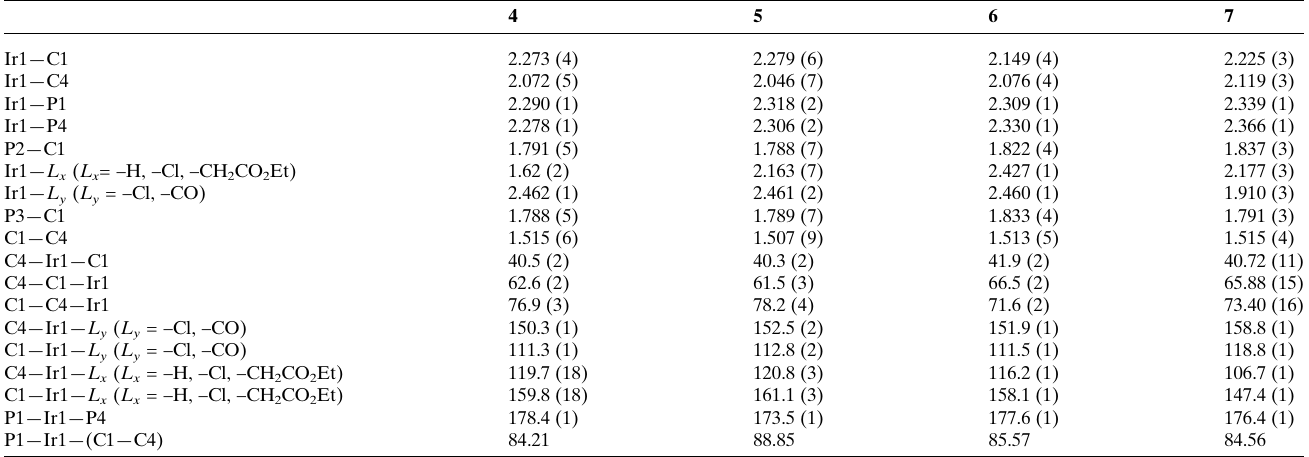
Table 1 Selected bond lengths (A˚ ) and angles ( (cid:3) ) of the compounds 4 , 5 , 6 and 7 .